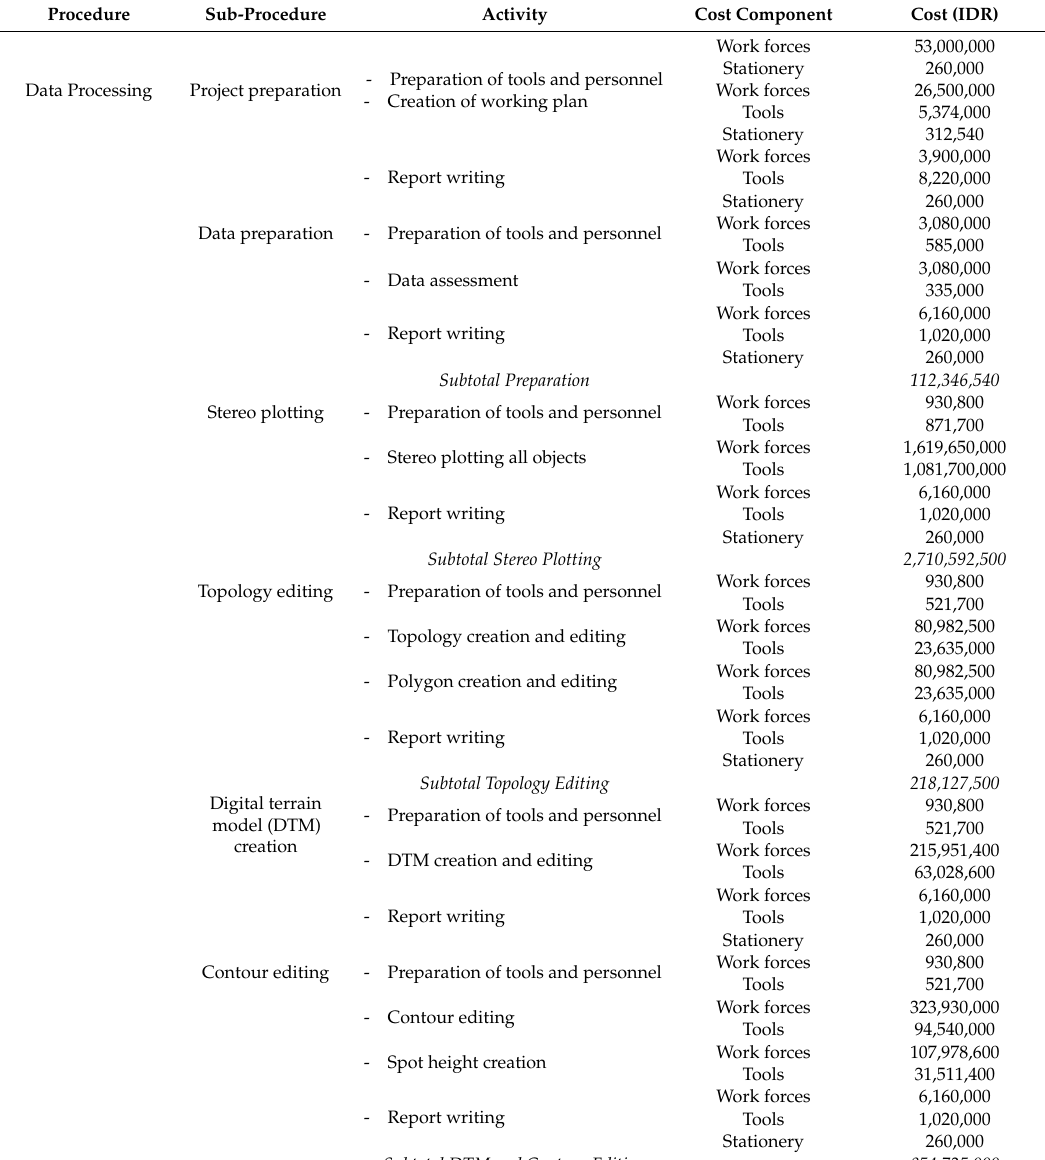
Table A4. Cost details of 1:5000 scale topographic mapping by the aerial photo